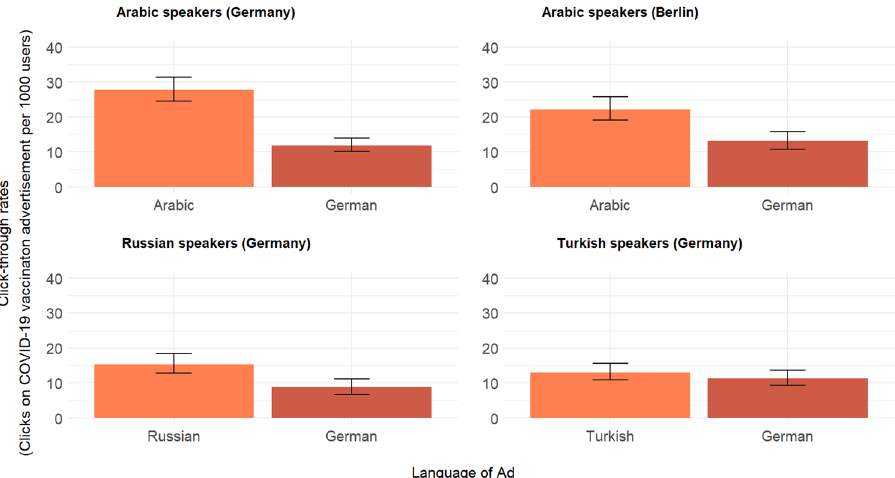
Figure 3. Clicks on COVID-19 vaccine advertisement per 1000 Facebook users by campaign location and language group, November and December 2021. Note: Pearsons chi-squared test yields significant difference in click-through rates between German and translated ads ( p < 0.001) for Arabic and Russian speakers. Differences for Turkish speakers are not statistically significant ( p > 0.05).